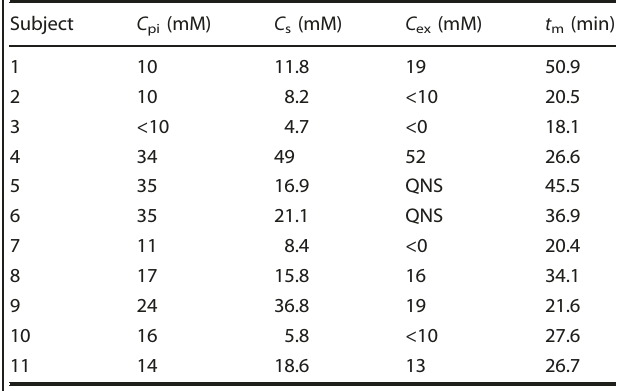
Fig. 1 Sweat test using a wearable sweat chloride sensor during walking. a Measurement of sweat chloride concentration and sweat volume using a wearable sweat chloride sensor and Macroduct device. b Optical images of the sweat sensor and the smartphone app. c Schematic illustration of the wearable potentiometric sensor. d Representative sweat chloride concentration pro fi le for an individual walking at 1.8 m s − 1 . e Corresponding sweat volume versus time curve. f The time corresponding to the onset of sweating ( t onset ) (mean ± SD). g The minimum measurement time ( t m ). h The sweat chloride concentration measured by the sensor. C s is the average value obtained from t s to the end of the trial. i Sweat volume per unit area collected in a Macroduct over 30 min from the beginning of the trial. ** P < 0.01. Table 1. Comparison of sweat chloride concentration obtained following pilocarpine iontophoresis or during walking at 1.8 m s − 1